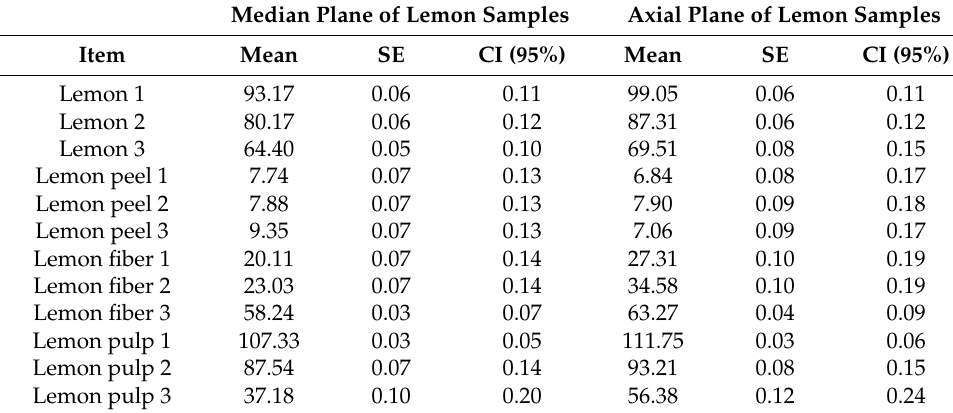
Table 1. The statistics of the X-ray imaging results of (1) fresh, (2) mature, and (3) overripe lemons based on the four-layer stratification of lemon, peel, fiber, and pulp after the linear attenuation of the lemon samples with fixed X-ray output exposure quality.